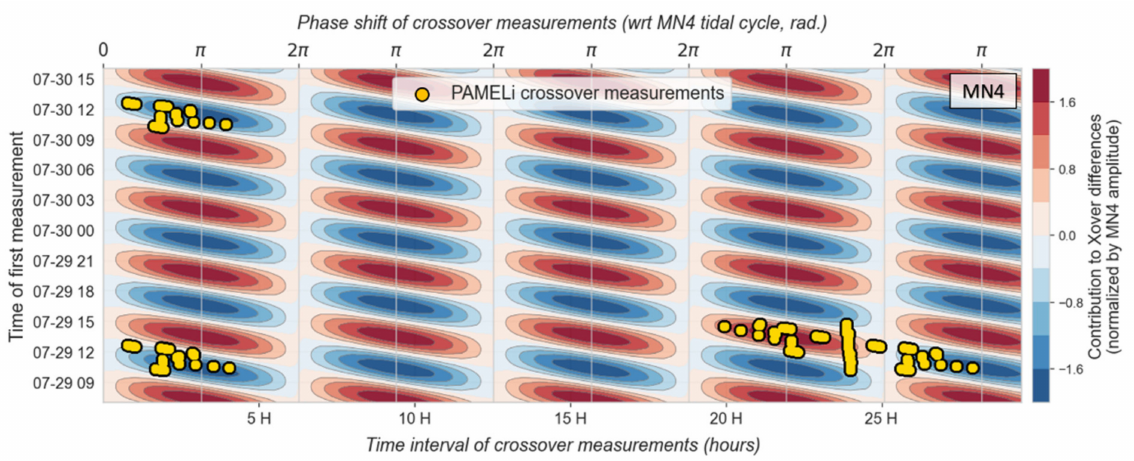
Figure 13. Contribution of MN4 to crossover differences ( DH k ), normalized by its amplitude. The PAMELi crossover mea- surements (yellow dots) are displayed with respect to their crossover time-intervals (bottom x -axis) and the corresponding phase shifts (top x -axis). The y -axis represents the time of crossover first